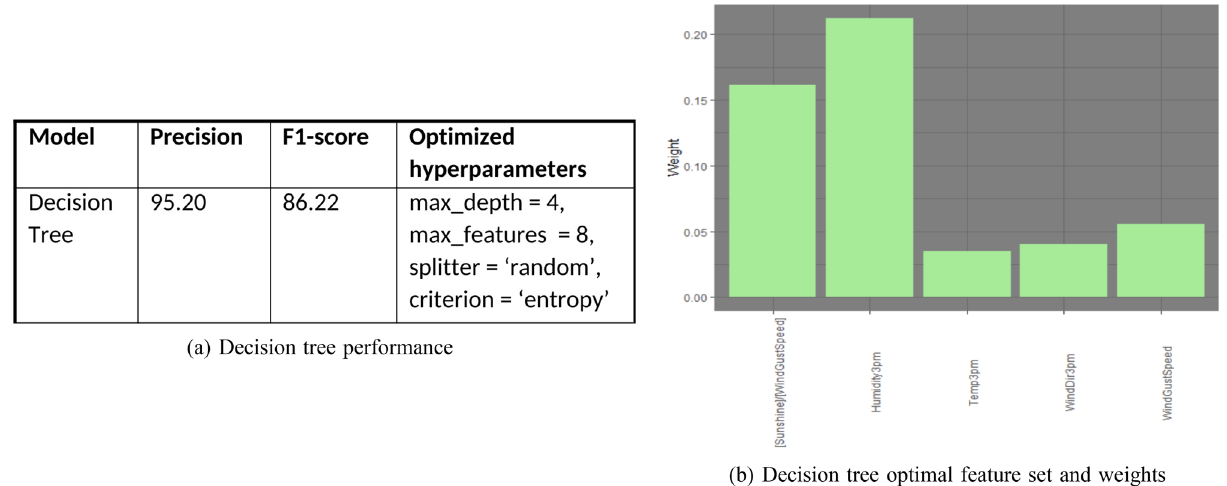
Figure 15. Decision tree performance and feature set.